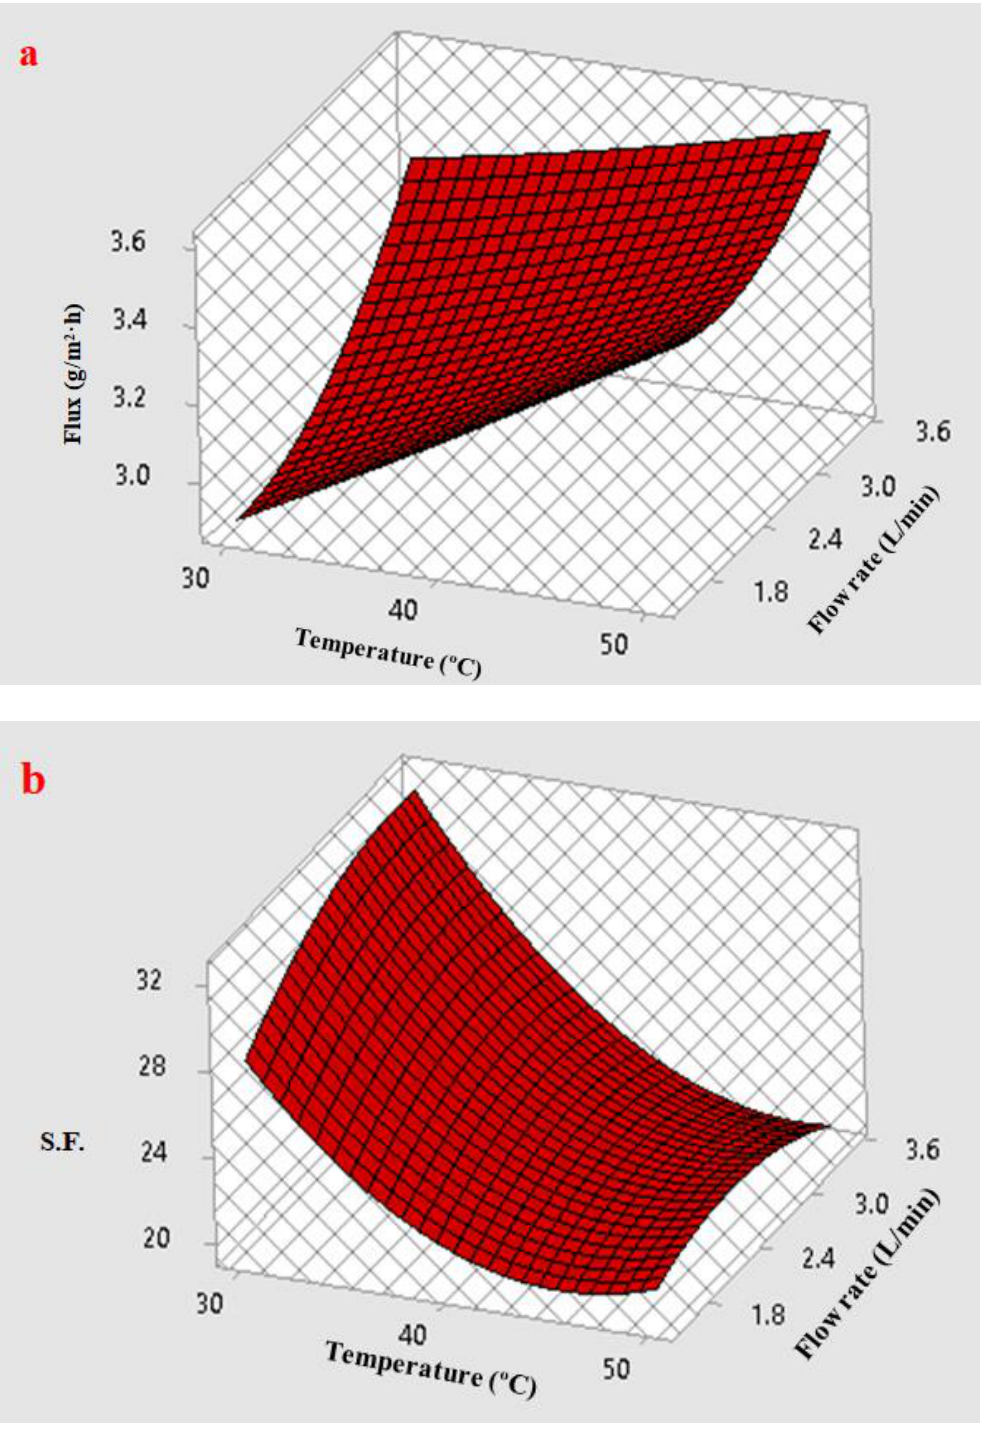
Figure 10. Effect of the feed temperature and feed flow on ( a ) benzene flux and ( b ) Separation factor (S.F.) at an initial benzene concentration of 550 ppm.